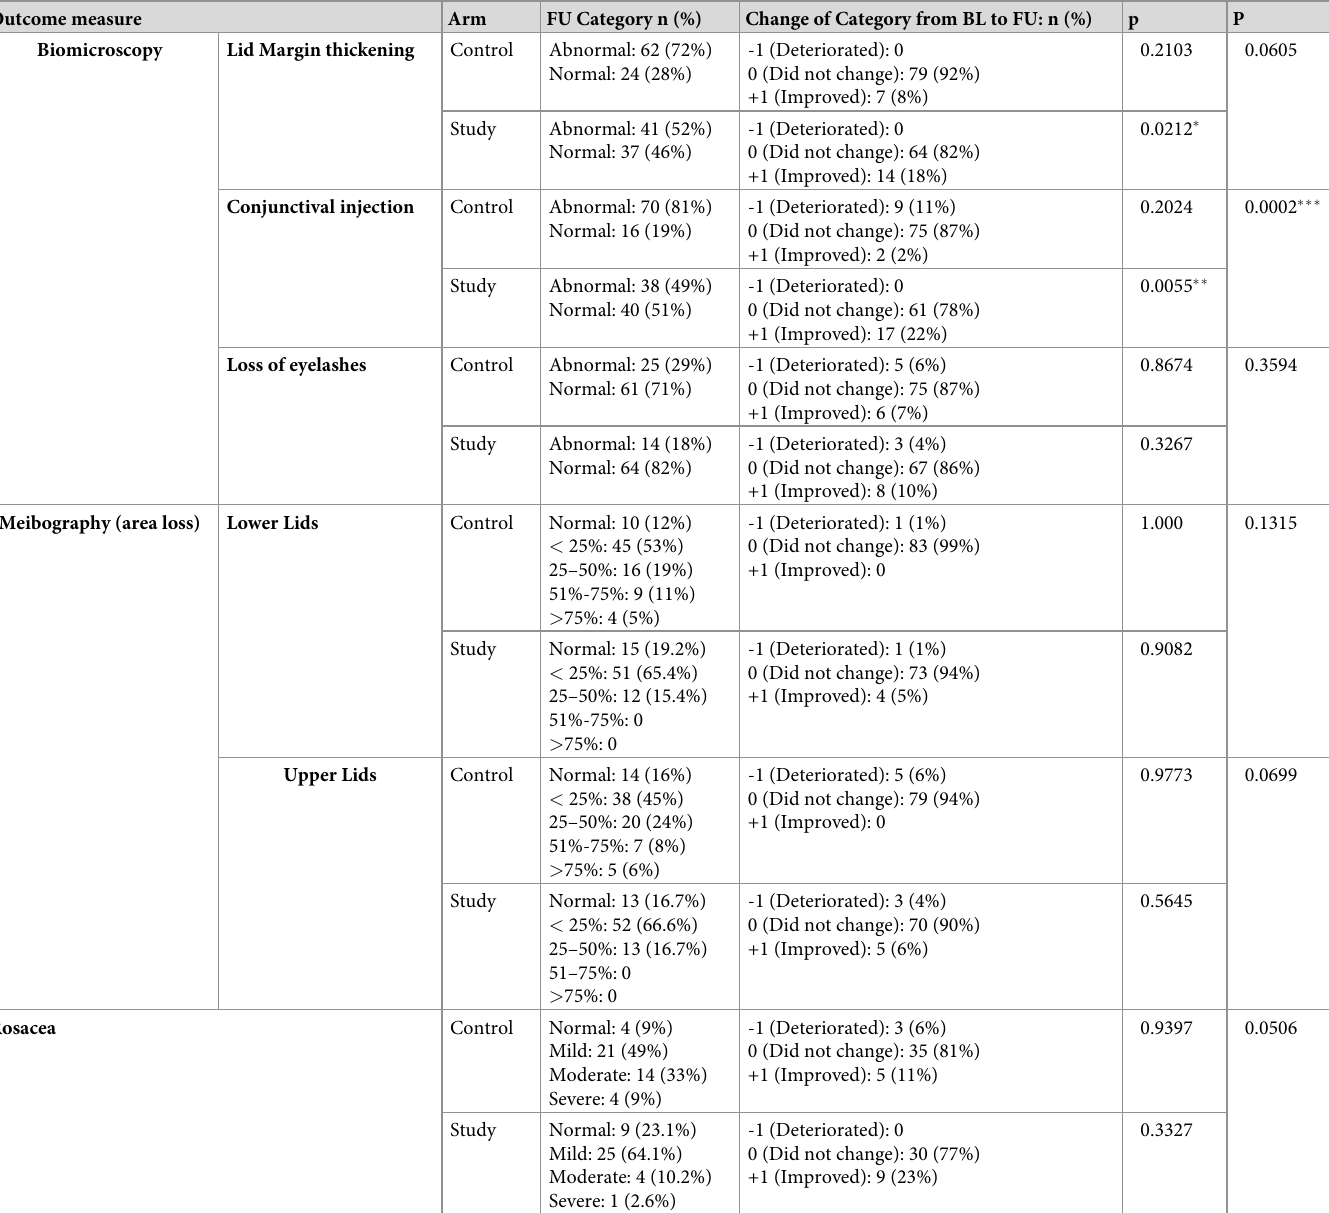
Table 3. Change of categorical outcome measures tested at BL and